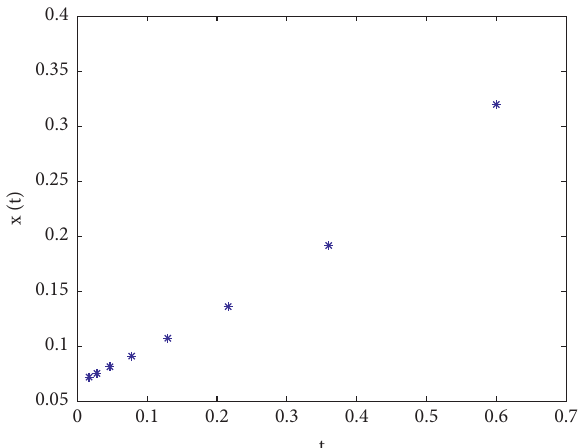
Figure 1: Behavior of the solution of system (62) in the ( t, x ) plane within T � 0 . 6s.